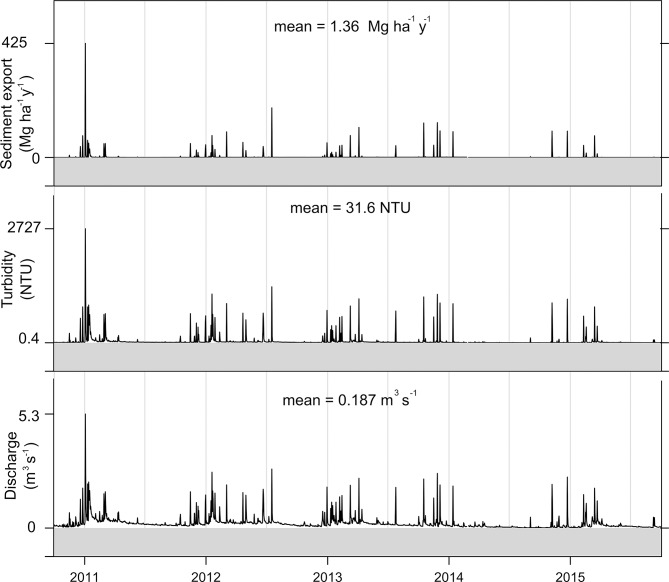
Temporal series of twice-a-day data of discharge (observed), turbidity (calculated with (Eq 1)) and sediment export (calculated with (Eq 3)) in the mouth of Posses Watershed, from October 2010 to September 2015.On the right, the percentage frequency distribution of the same variables.